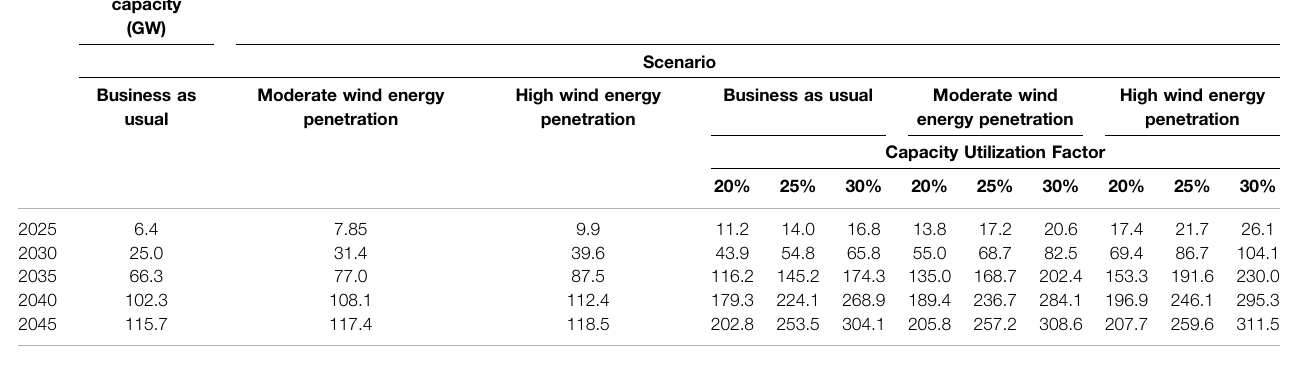
TABLE 5 | Wind power and electricity generation cumulative capacity in Pakistan under various scenarios.